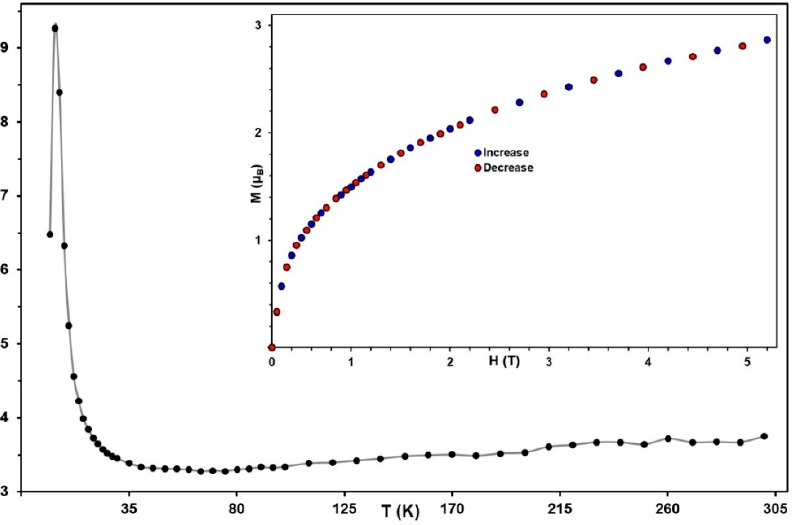
Figure 14. Magnetic dc plots for 12 . Temperature dependence of χ T at H = 1000 Oe (solid line). Inset: magnetization versus the field at T = 2 K [46].